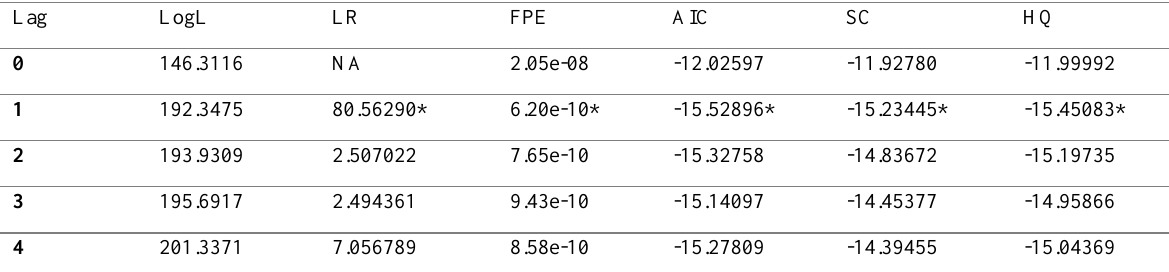
Table 8: Lag Length